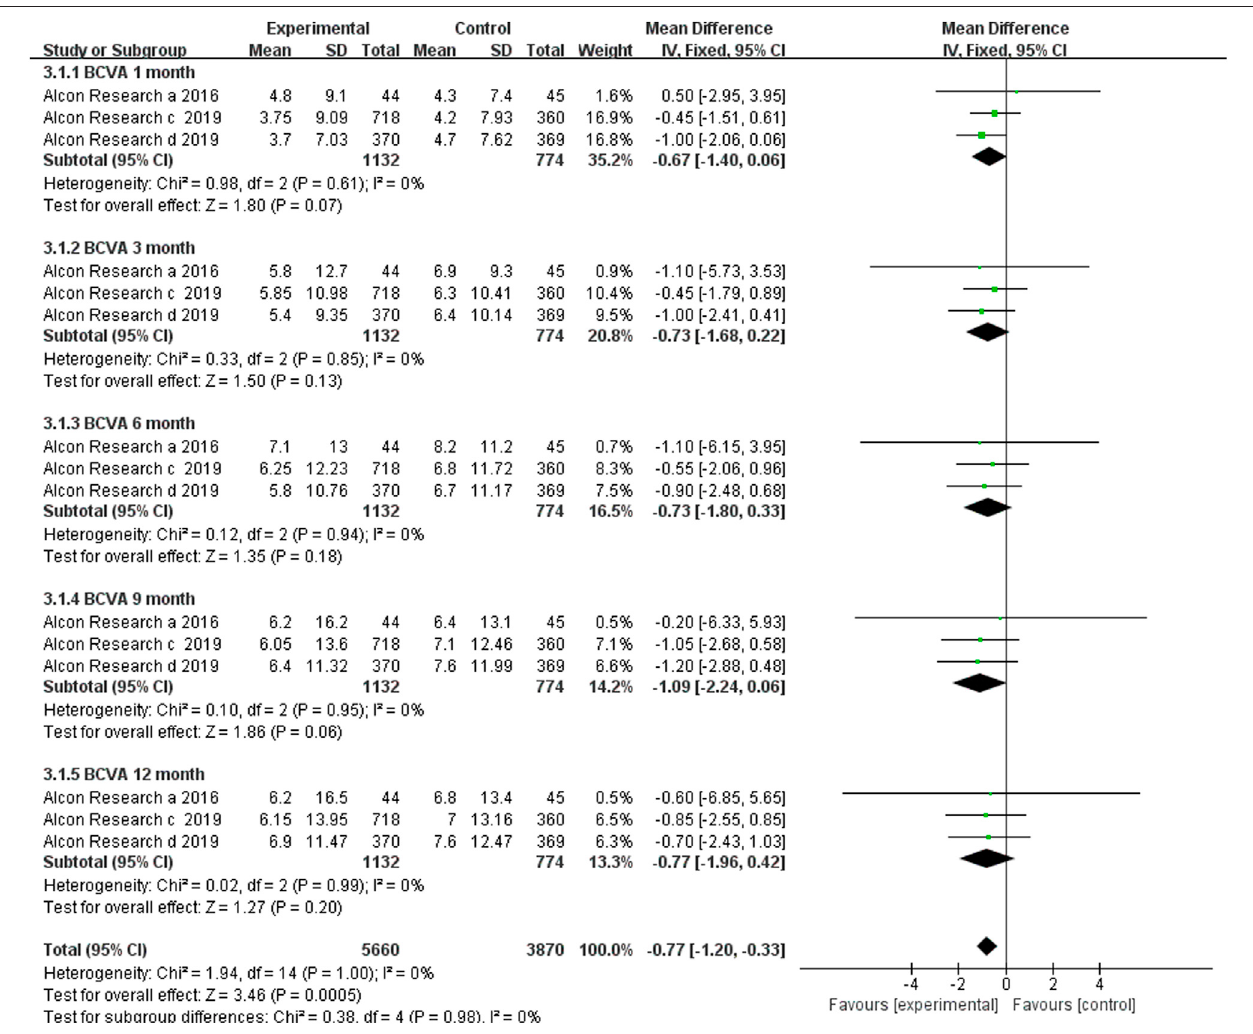
FIGURE 3 | Comparison of the effect on BCVA between the brolucizumab-treated group and control group.